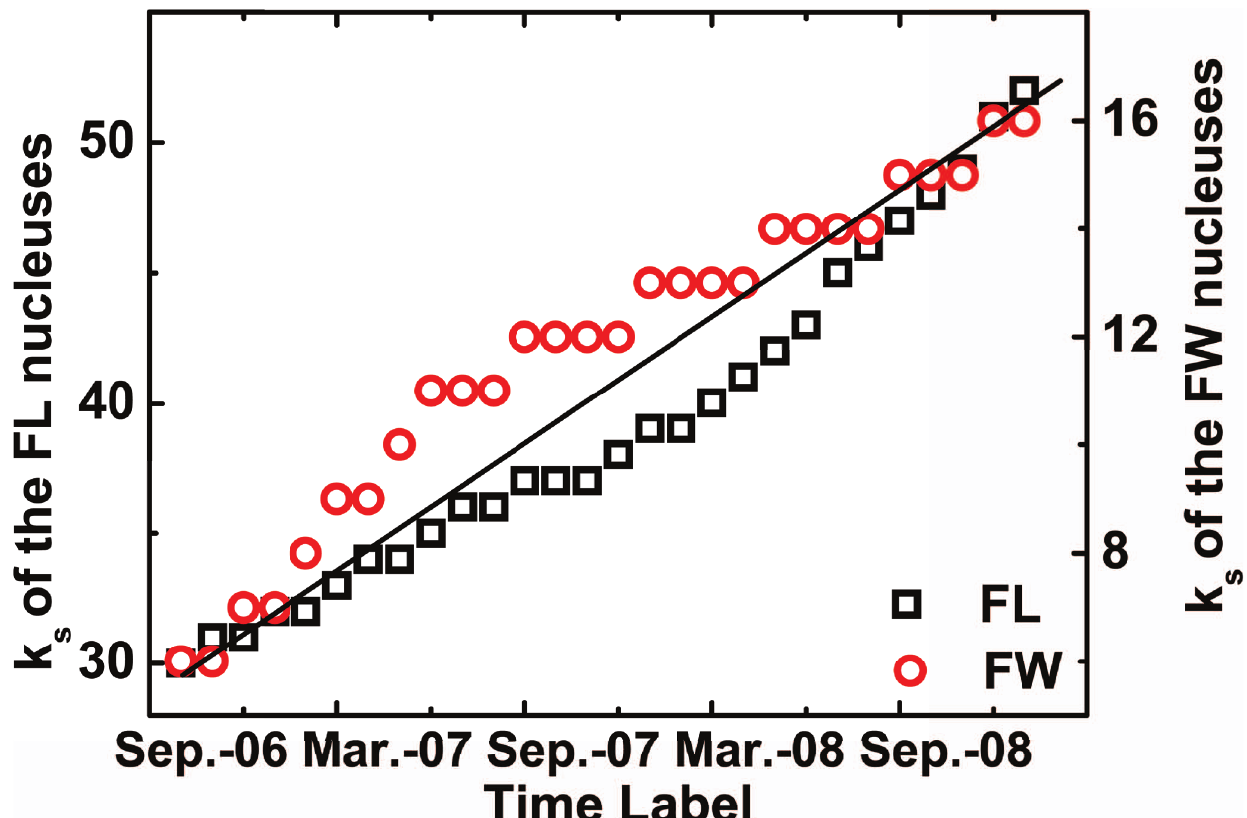
Figure 3. (Color online) The k s values of each core in the FL and FW networks.